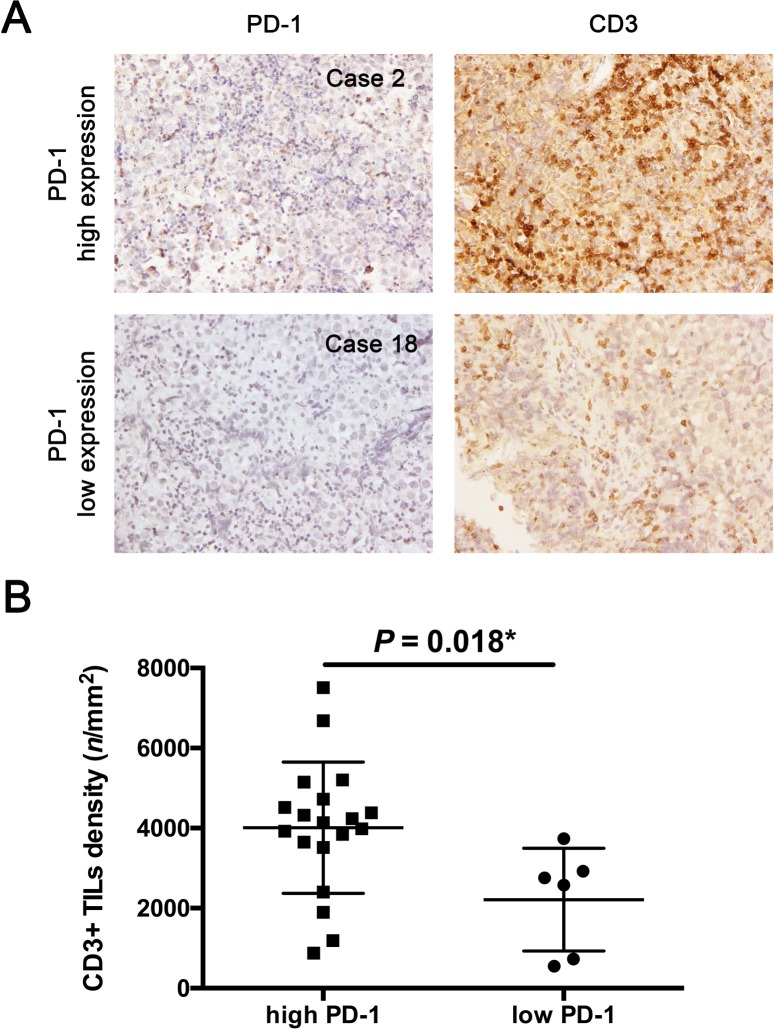
Expression of PD-1 correlated with total TIL density (CD3+).(A) Representative immunohistochemical images of PD-1 and CD3 proteins show that CD3+ TIL density was higher in patients with high expression of PD-1 (Case 2) than in the patient with low expression of PD-1 (Case 18). Figures were taken from the same areas of tissue, respectively. (B) Unpaired Welch’s t testing reveals that CD3+ TIL density was higher in primary germinoma cases showing high expression of PD-1 (P = 0.018). Black arrow, TIL; white arrow, cancer cell. Original magnification: ×400.